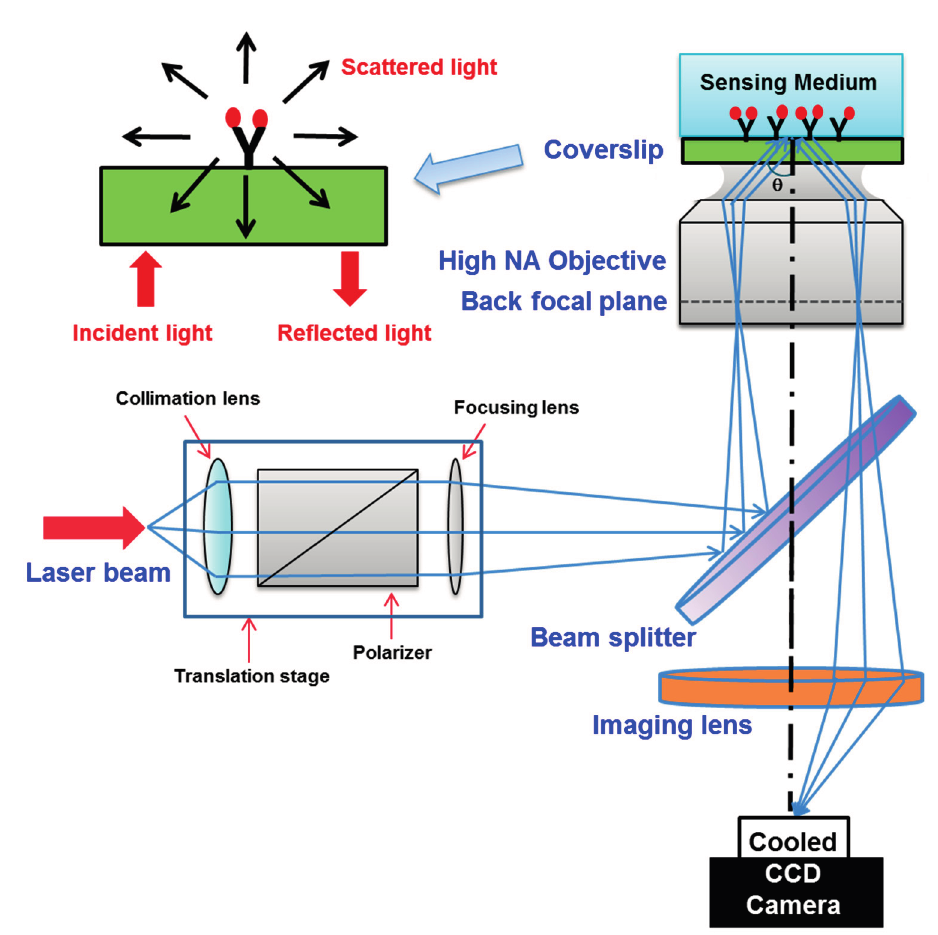
Figure 11. General principle of the objective-type SPRI setup. The optical configuration of the SPR microscope. Adapted from